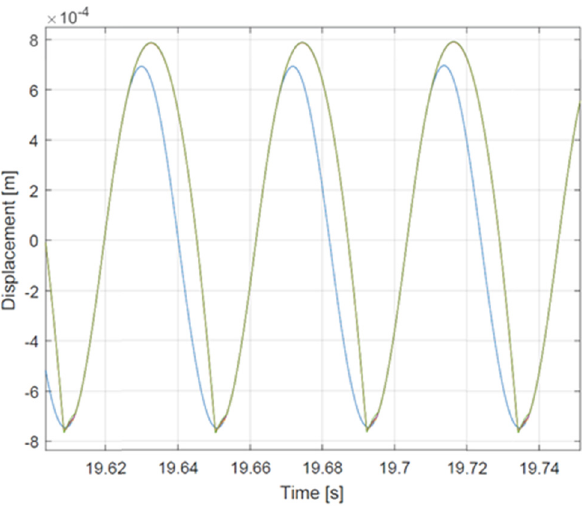
Figure 5: Trough oscillations ( blue line ) carrying feed